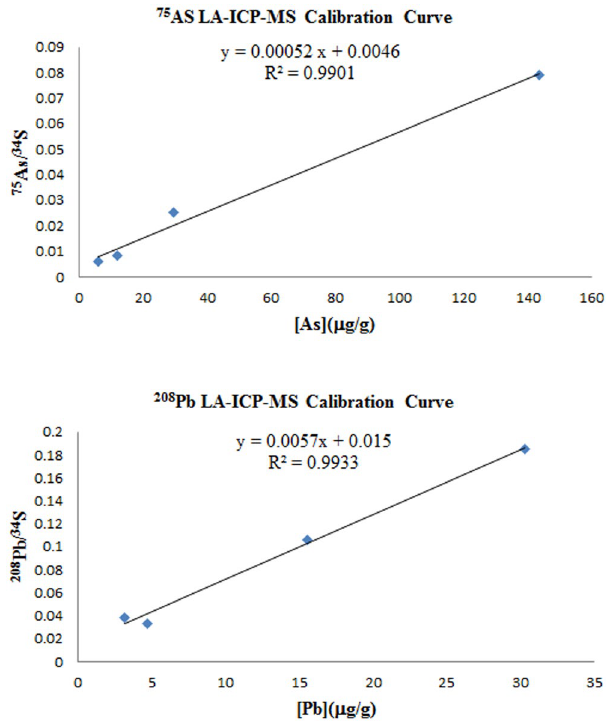
Figure 2. Arsenic and lead calibration curve from the analysis of ten in-house hair standards (R2 = 0.9901 and